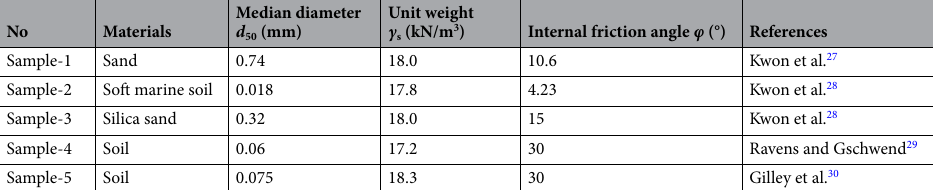
Table 4. Fundamental physical parameter values collected from different references.